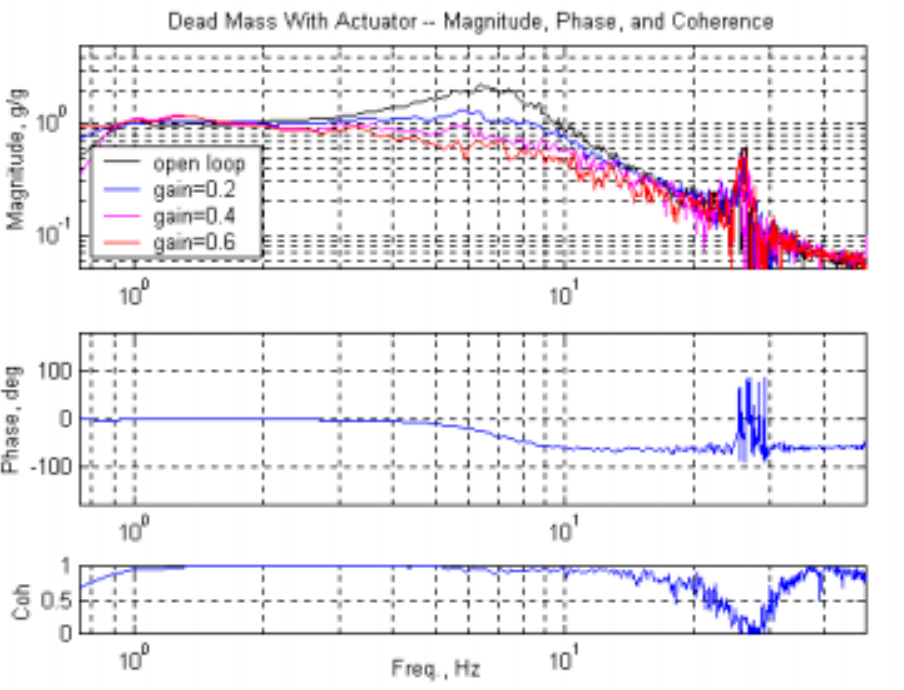
Fig. 13. Measured transmissibility plots illustrating the effects of feedback